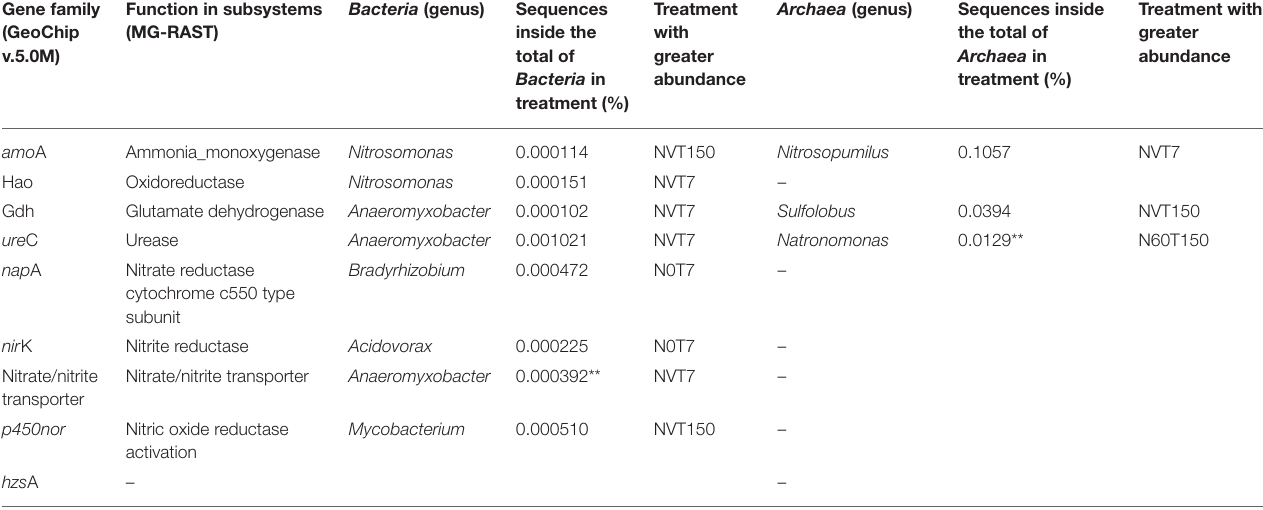
TABLE 3 | Archaea and Bacteria frequencies of functions in metagenomes corresponding to N cycle gene families selected by GeoChip v.5.0M. Gene family (GeoChip